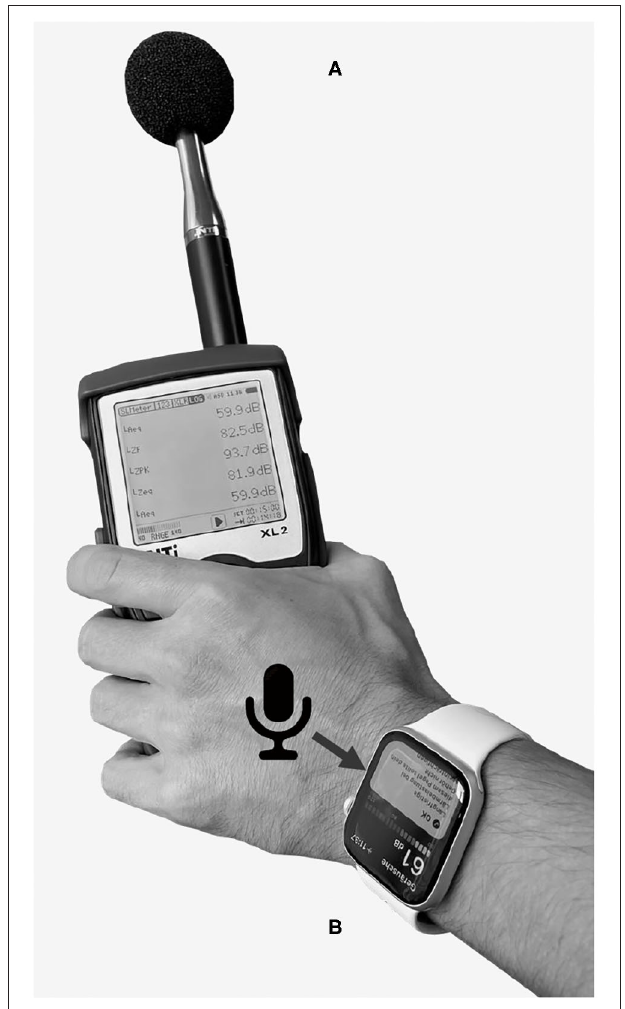
FIGURE 1 | Measurement configuration of the sound level meter (A) and smartwatch (B) during noise level assessment. The arrow points to the microphone opening of the